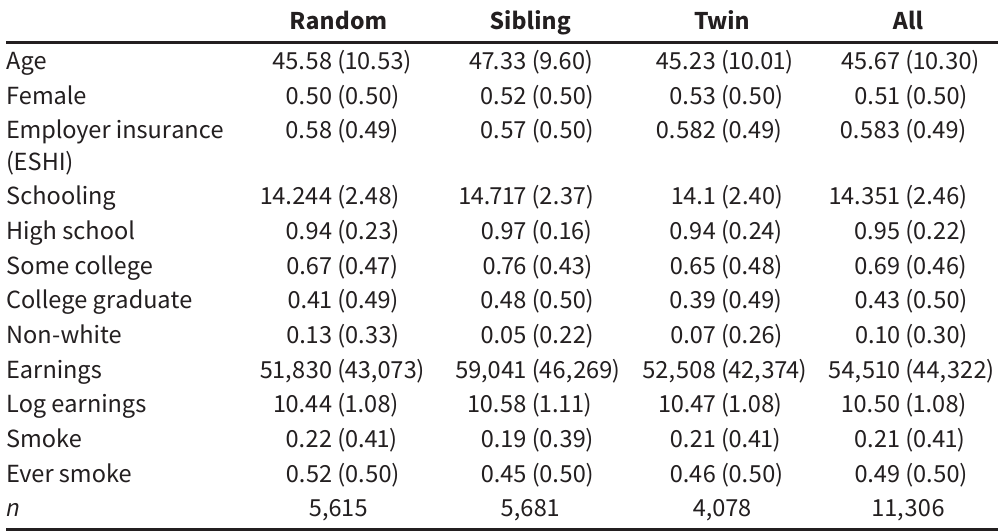
Descriptive statistics for The National Survey of Midlife Development